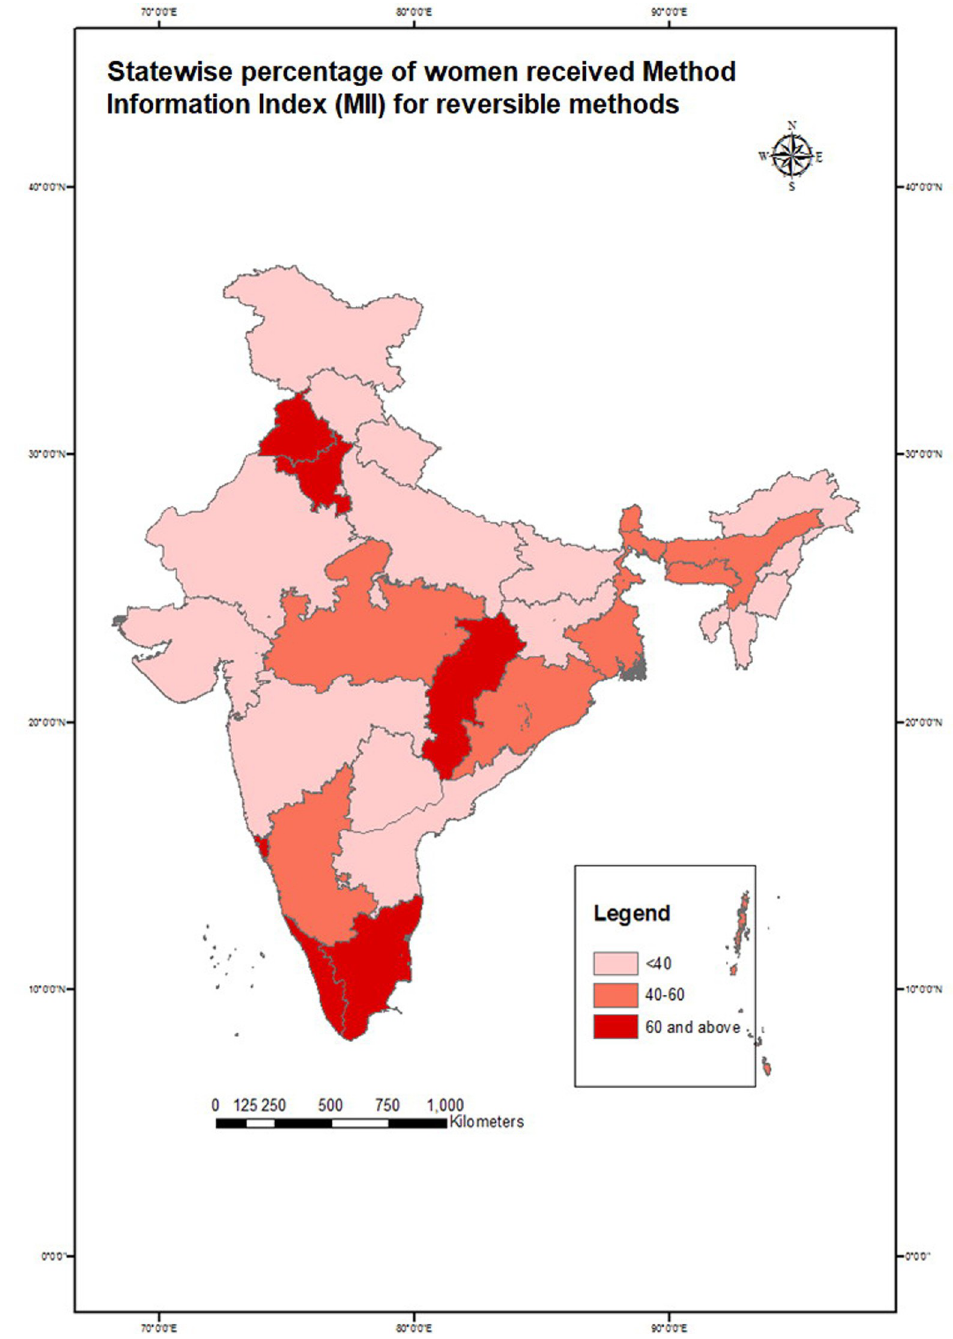
Fig 5. Method information index (in percentage) among married women aged 15–49 years who are currently using reversible modern contraceptives in India, NFHS 2015–16.